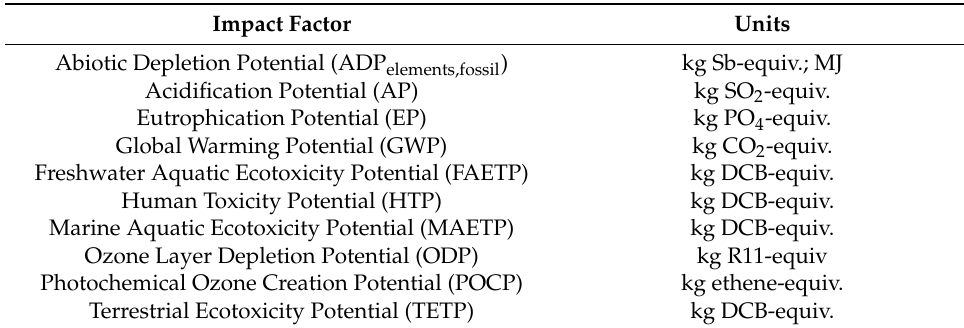
Table 1. Environmental indicators and its